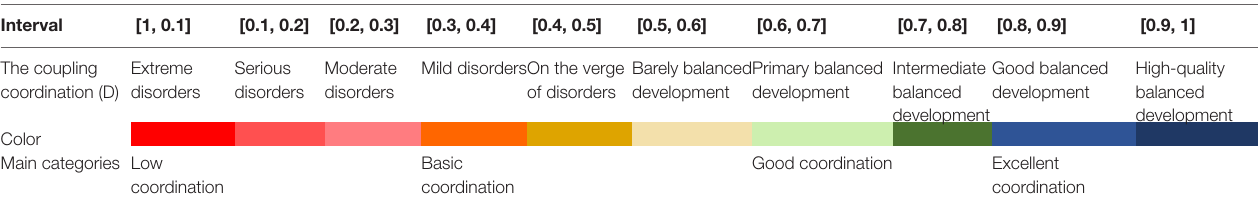
TABLE 3 | Classification standard for the degree of coupling